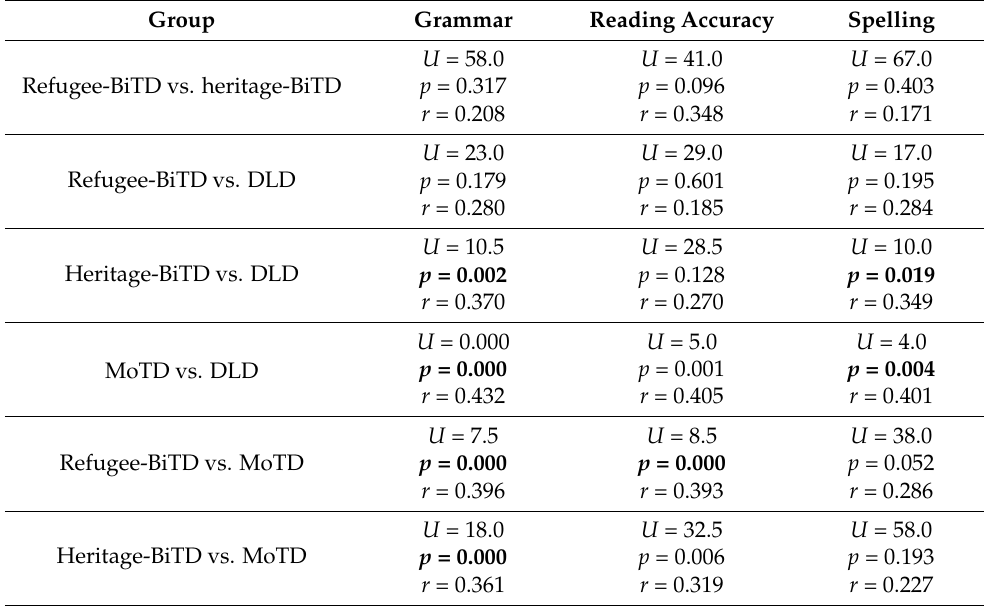
Table A2. Performance on BUEGA subtests: between-group comparisons (Mann–Whitney U tests), significant comparisons are given in